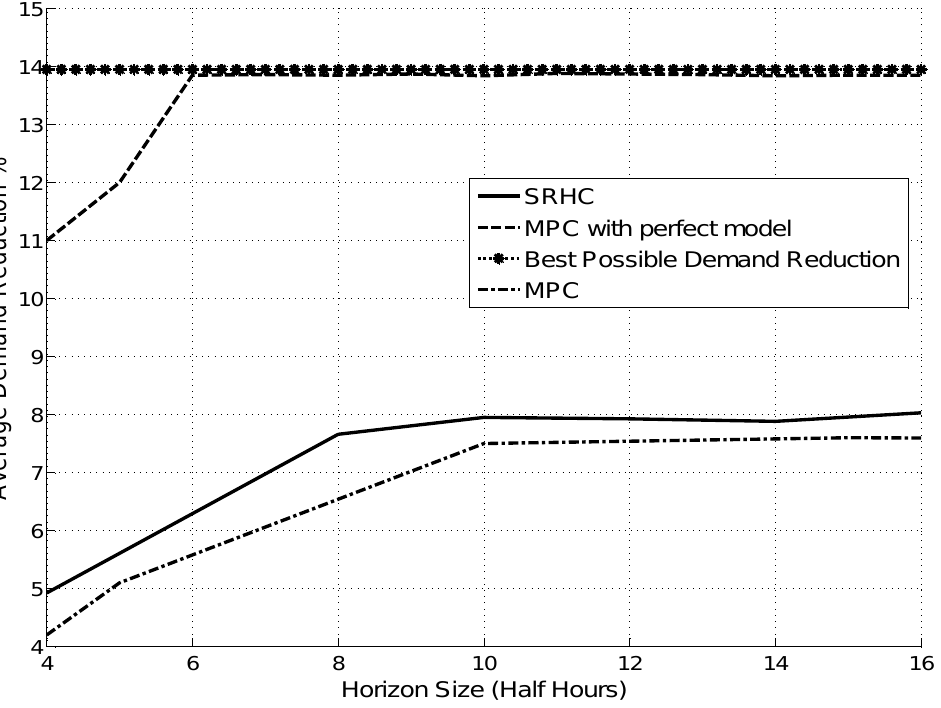
Figure 7. Algorithm performance vs . horizon size for the SRHC, MPC, MPC with a perfect demand model and the best possible demand reduction given a perfect demand